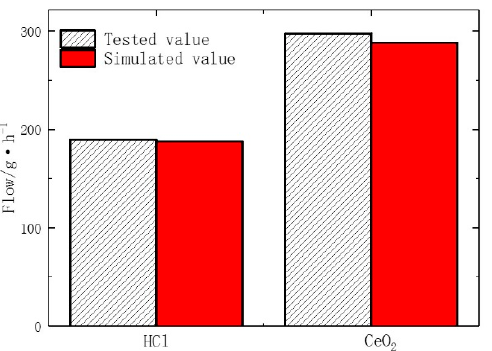
Figure 2. Comparison of numerical simulation results and experimental results (HCl outlet and CeO 2 ).